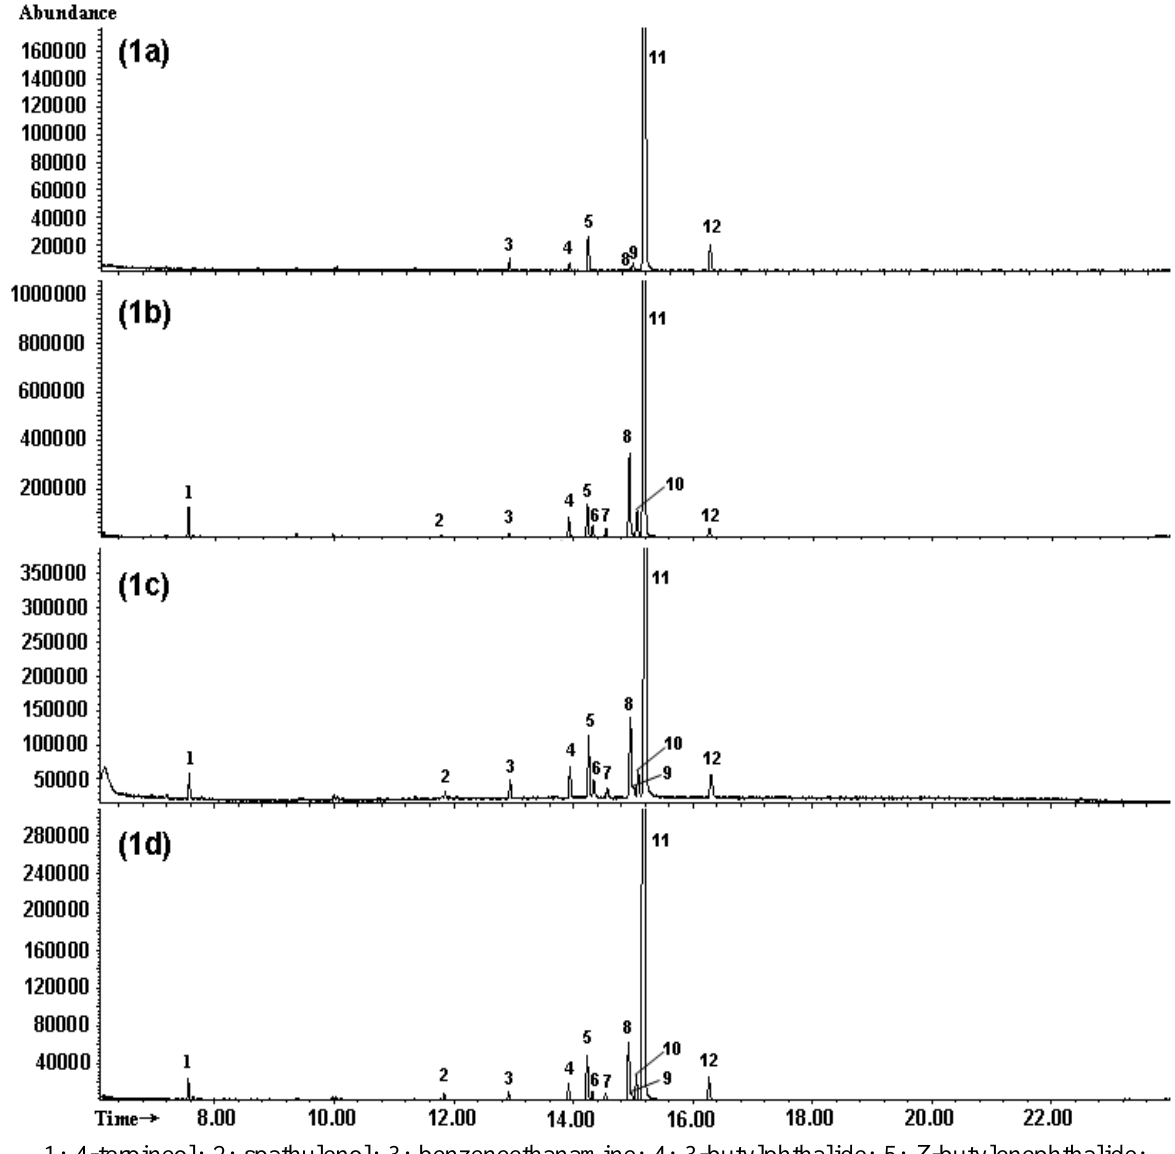
Figure 1. GC-MS total ion chromatograms for essential oils from RA (1a) , RL (1b), FSS (1c), and SWT